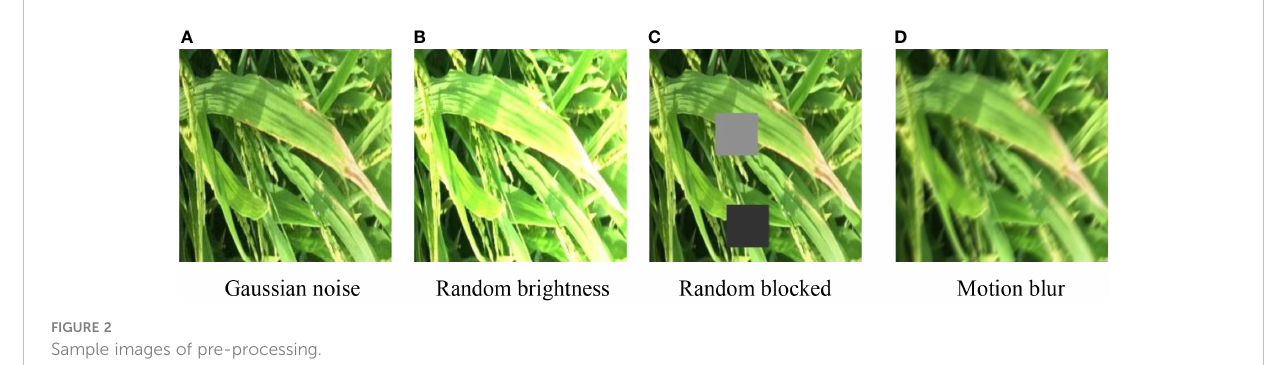
FIGURE 2 Sample images of